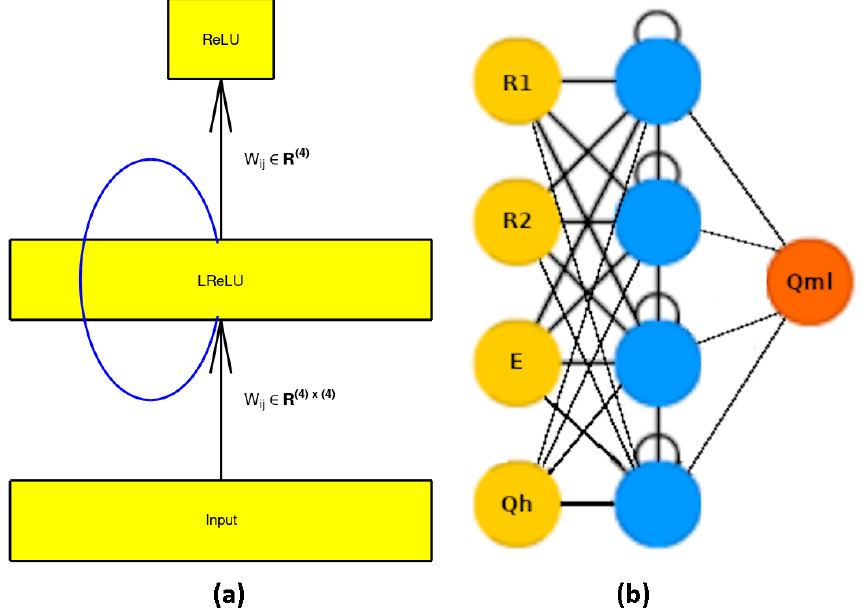
Figure 7. Example of an ML approximator (cid:98) Φ ( x ) of the best feasible model Φ ( x ) . Left panel ( a ) displays the activation functions (LReLU and ReLu), the dimensions of the weight matrices and the recurrent (indicated with a blue ellipse) hidden layer. Right panel ( b ) displays the inputs and outputs of the employed ML approximator. The assessed hydrological model has three inputs (precipitations R1 and R2, and evapotranspiration E) and one output (Qh). These are the four inputs of the ML approximator. If the ML approximator output, Qml, is closer to the observations than the hydrological model output, Qh, then there is some information in the data that the structure or setup of the hydrological model is not taking into